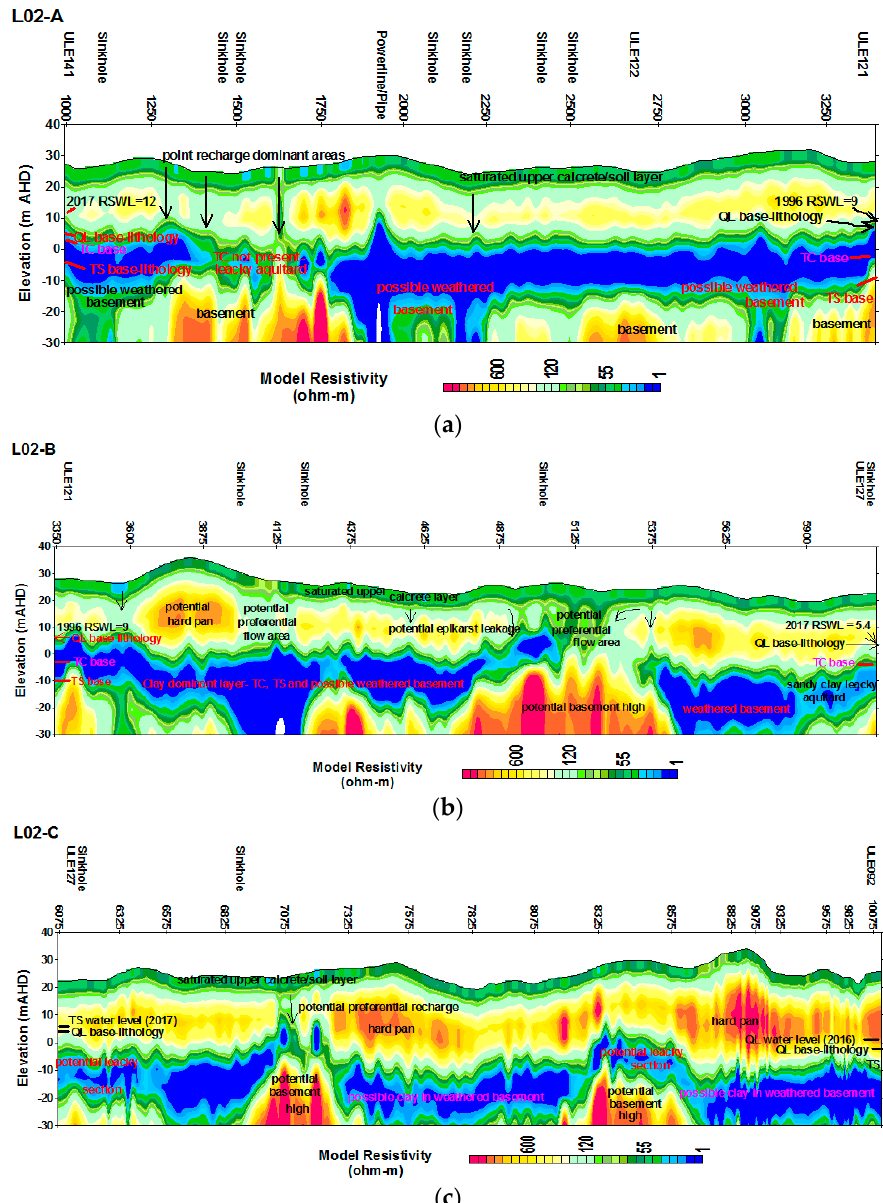
Figure 8. TEM sections for LO2; ( a ) LO2-A (from ULE141 to ULE121); ( b ) LO2-B (from ULE121 to ULE127); ( c ) LO2-C (from ULE127 to ULE092).